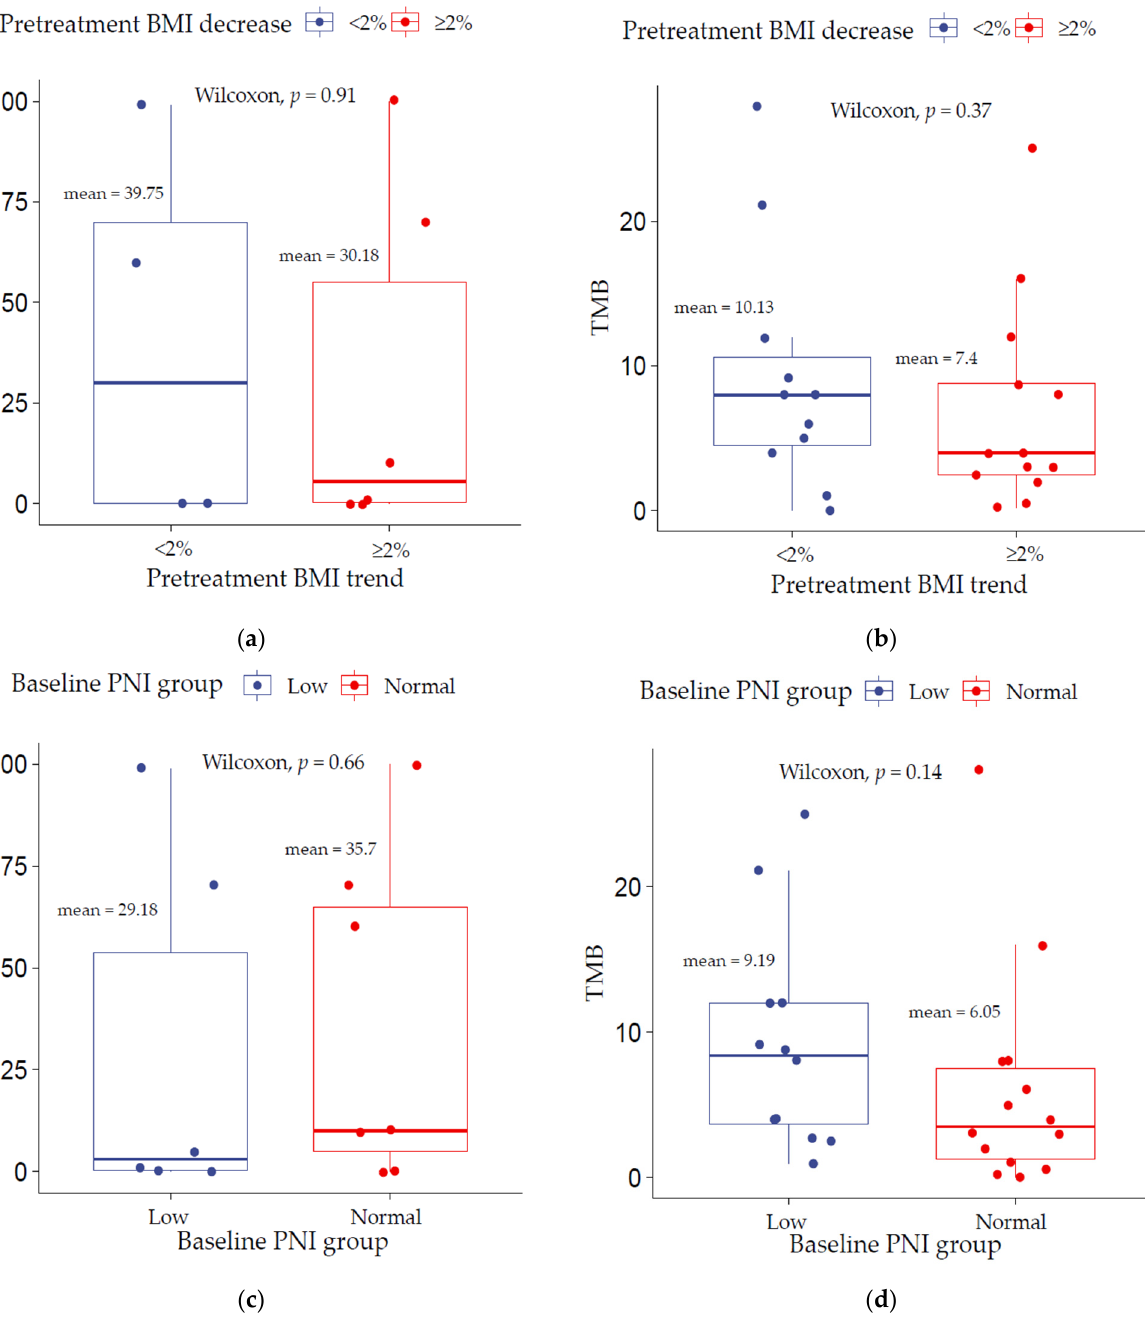
Figure 2. TMB and PD-L1 correlation analysis stratified by ( a ) and ( b ) pretreatment BMI trend and ( c ) and ( d ) baseline PNI group.